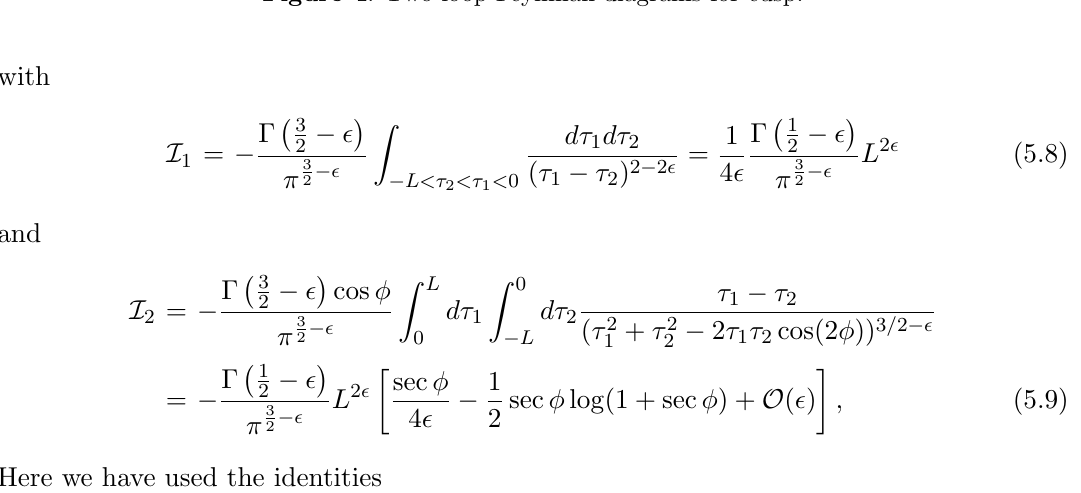
Figure 4 . Two-loop Feynman diagrams for